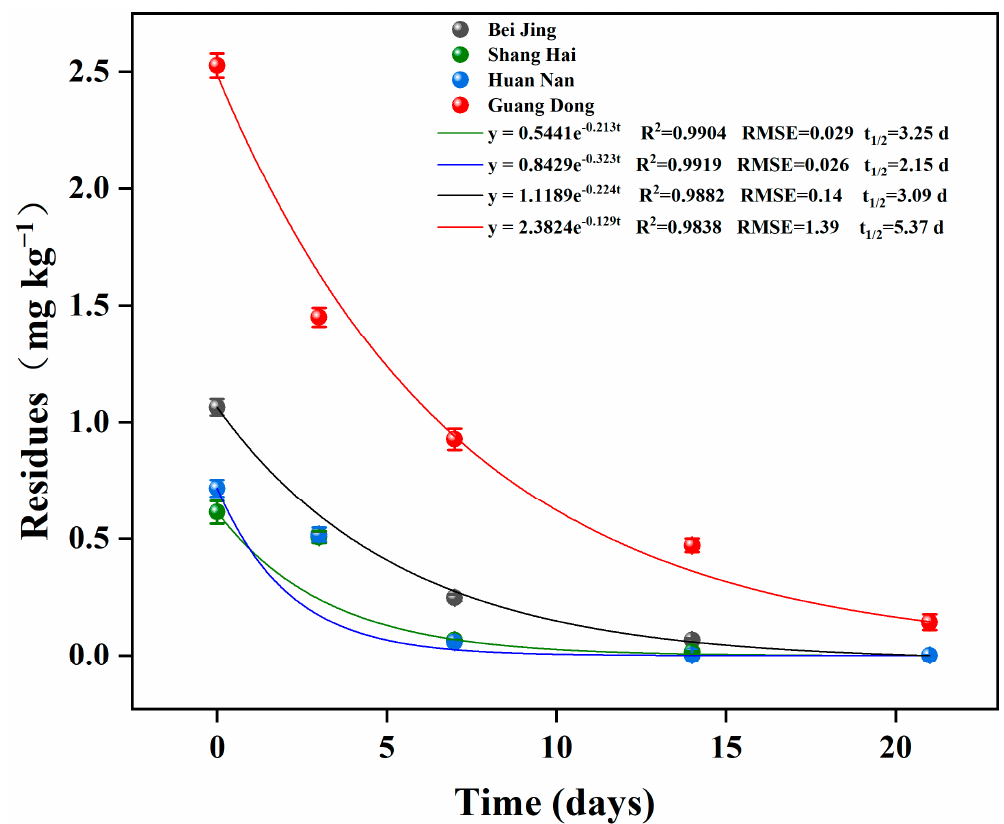
Figure 3. Dissipation behavior of chlorfenapyr in cabbage in four regions in China.